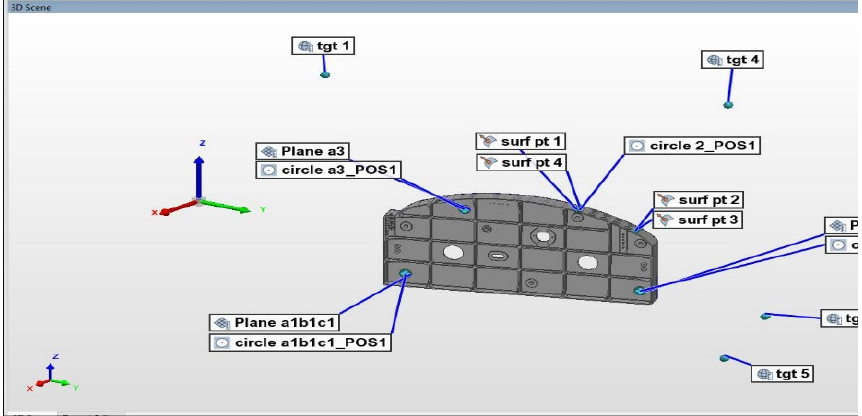
Figure 36. Illustration from 3rd party metrology software application, i.e., Polyworks Inspector GUI (Graphical User Interface).